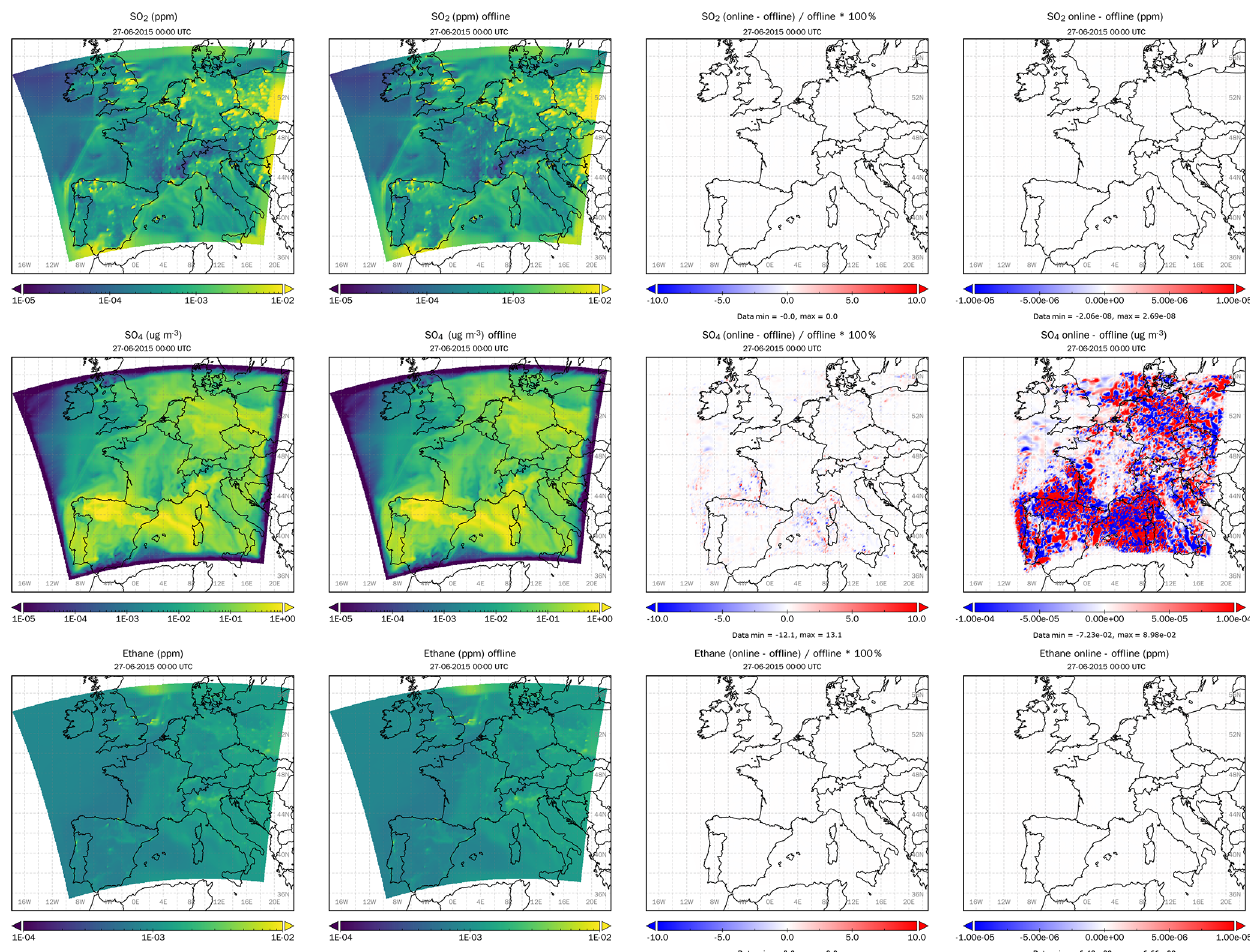
Figure 4. Surface-layer concentrations for the online and offline simulations and relative and absolute differences between online and offline simulations in the COSMO-ART test case for surface layer fields of SO 2 (top), SO 4 (middle), and ethane (bottom) after 24h.